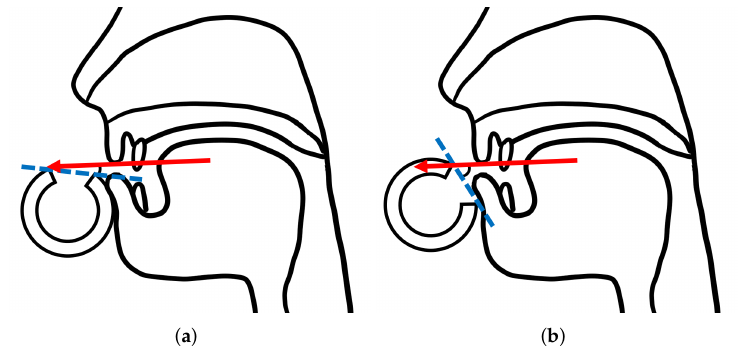
Figure 5. Angle labels for human performance. ( a ) Label “BACK”. ( b ) Label “FRONT”.